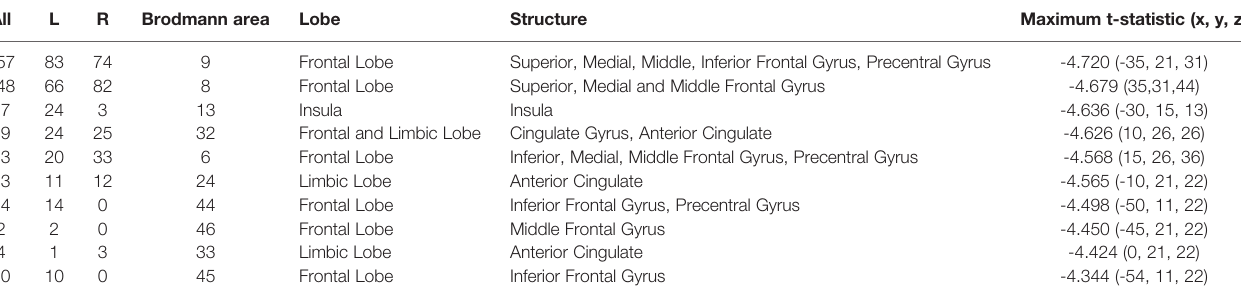
TABLE 2 | Number of voxels, Brodmann areas and anatomical region where signi fi cant differences in baseline exact low-resolution brain electromagnetic tomography (eLORETA) current density were found for alpha-2 frequency band (10.5 – 12 Hz), comparing responders and non-responders to repetitive transcranial magnetic stimulation (rTMS)